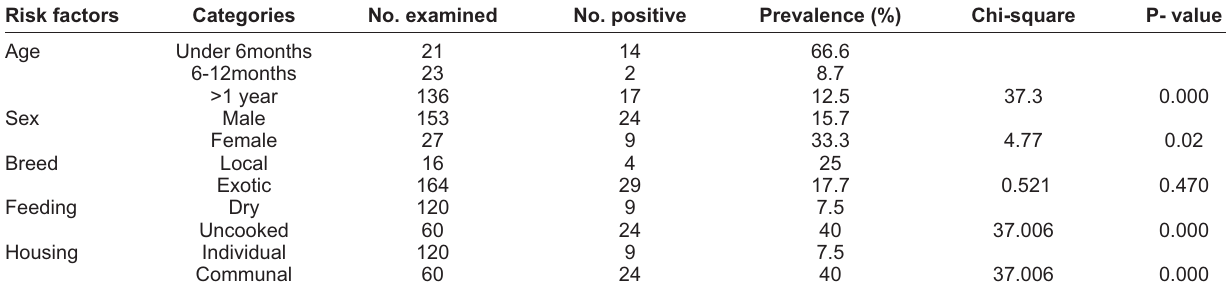
Table-2: The risk factors effect on enteric parasites affection in police and house dogs. Risk factors Categories